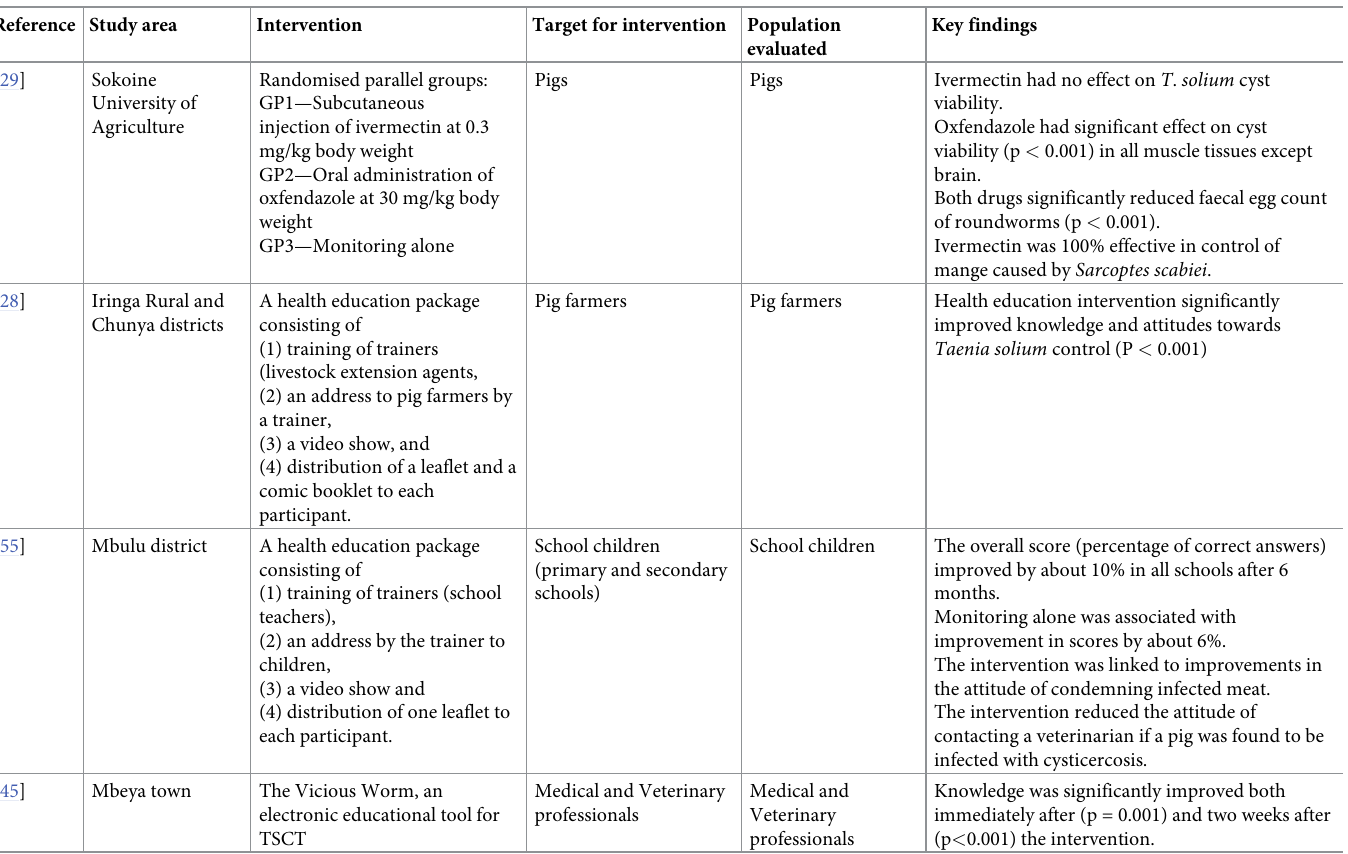
Table 5. Efficacy of Taenia solium control tools previously evaluated in Tanzania,